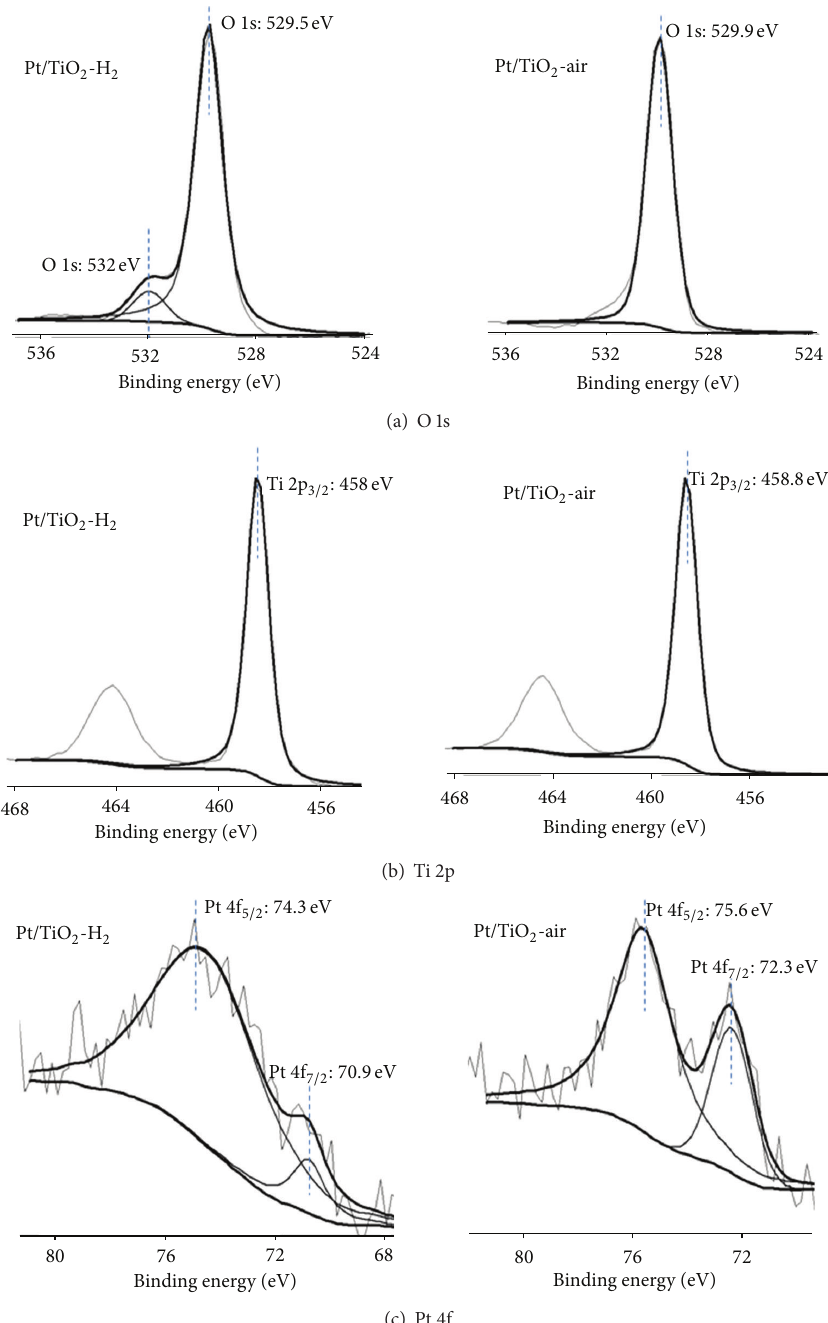
Figure 5: XPS spectra of the Pt/TiO 2 -H 2 and Pt/TiO 2 -air